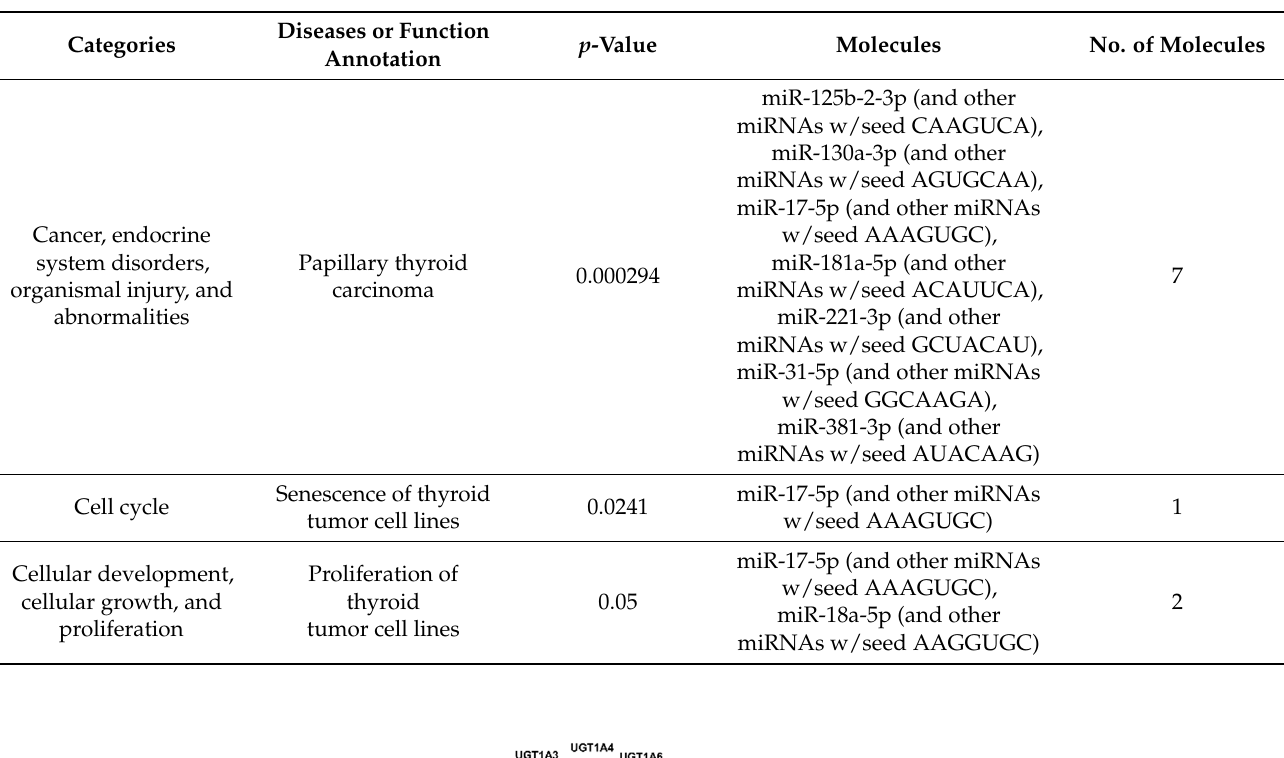
Table 5. Downregulated miRNAs linked to thyroid cancer.